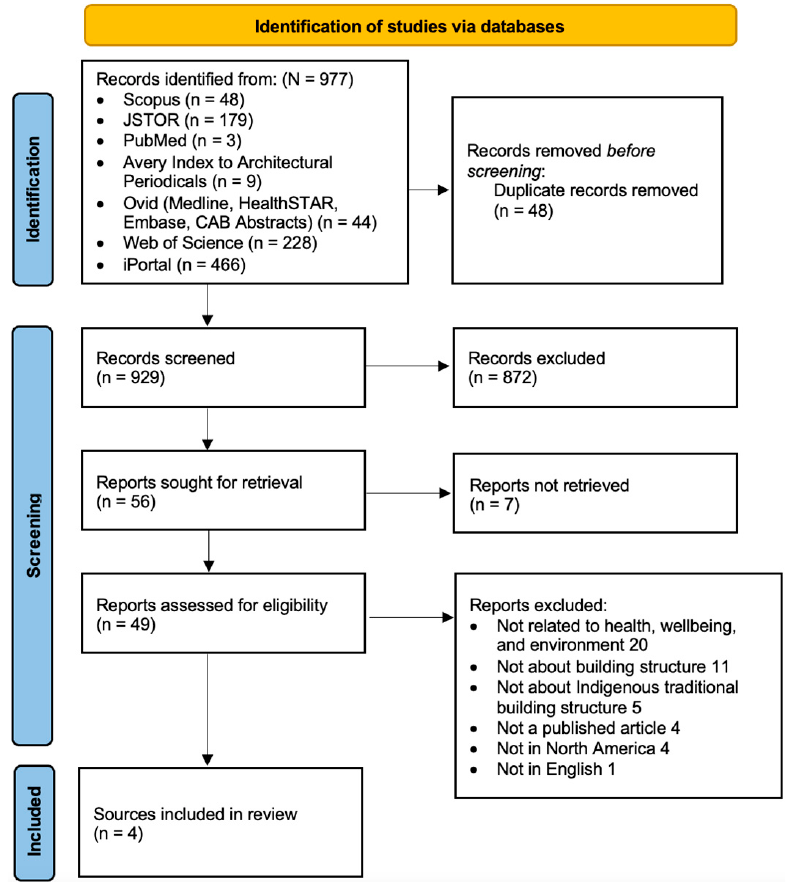
Figure 1. PRISMA flow diagram of the study-selection process.